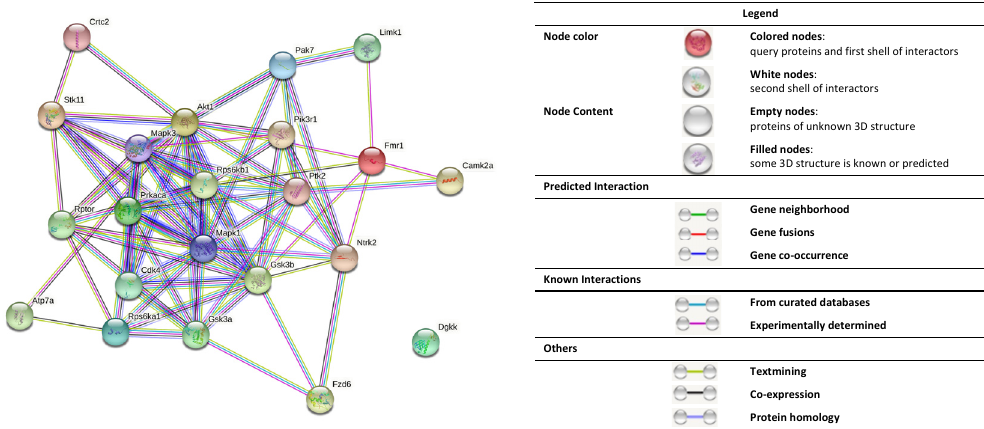
Figure 4. Network interaction of protein kinases that are dysregulated by loss of FMRP. A protein interaction network was generated by String Version 11.5 and summarizes the predicted associations of all the protein kinases mentioned in the literature regarding FXS. Protein kinases are represented by colored network nodes in relation to each other and to the Fragile X-causing protein FMRP. The edges illustrate functional associations and the lines between the nodes represent existence of evidence for associations. A more detailed legend of the node colors, content, and predicted and known interactions is provided in the graphic legend.